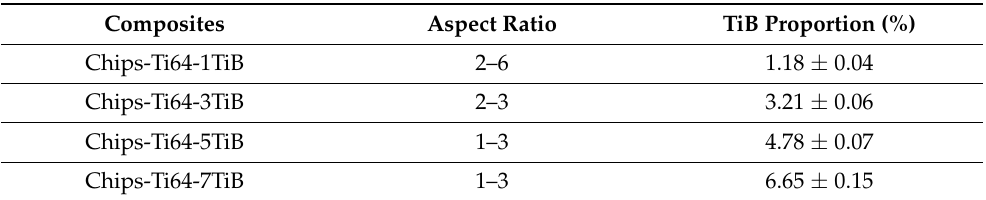
Table 3. Aspect ratios and proportion of the TiB whiskers of the TiBw/Ti-6Al-4V composite with different boron additions.